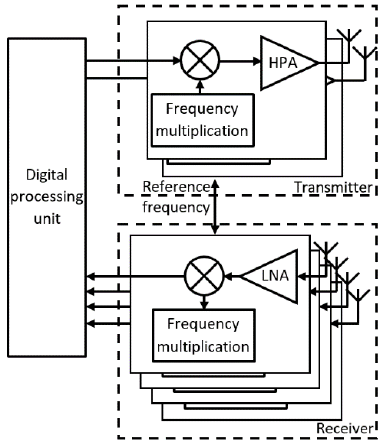
Figure 5. Typical 2Tx4R MIMO radar architecture.